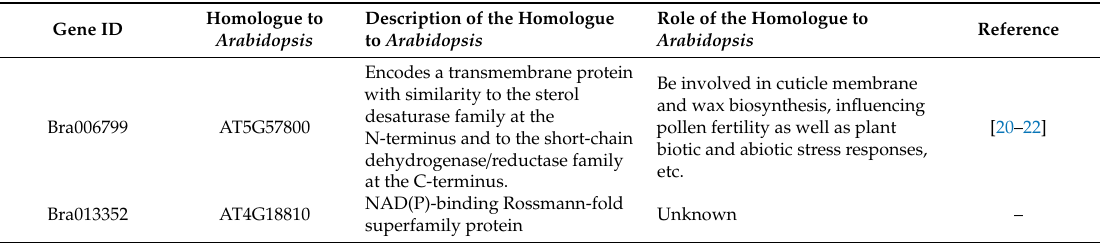
View of the DEcircRNA–DEmiRNA–DEmRNA triple network involved in anther development in Bcajh97-01B (fertile line) and Bcpol97-05A (sterile line) of Brassica campestris. The network includes one circRNA, two miRNAs, five mRNAs, and 11 edges. circRNA, miRNA, and mRNA are indicated as a deformed V, diamonds, and ellipses, respectively. The red color represents the up-regulated expression, and the blue color represents the down-regulated expression. Table 8. Differentially expressed mRNA putative targets of ‘A02:23507399|23531438 ′ in Bcajh97-01B (fertile line) and Bcpol97-05A (sterile line) of Brassica campestris.